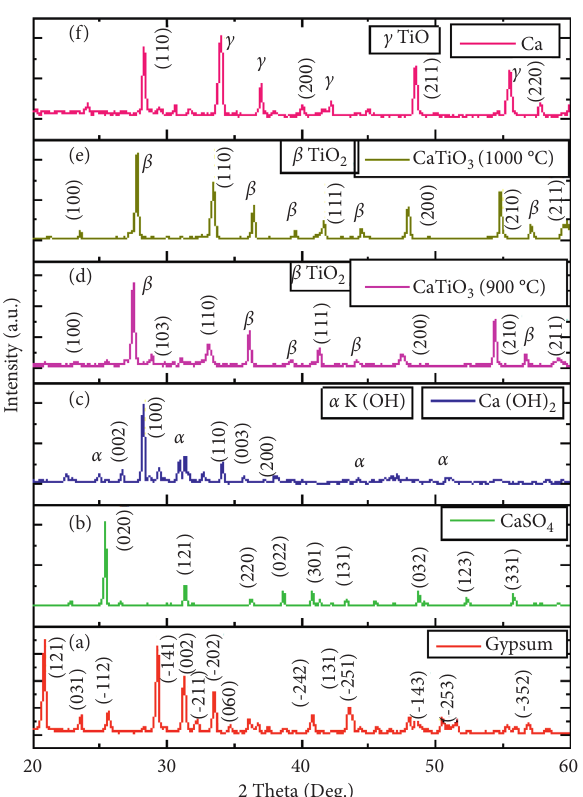
Figure 4: XRD patterns obtained at different CaTiO steps. incomplete reaction. The Pbnm space group indicates the orthorhombic phase. The crystallographic parameters ob- tained from the XRD analysis are given in Table 2.